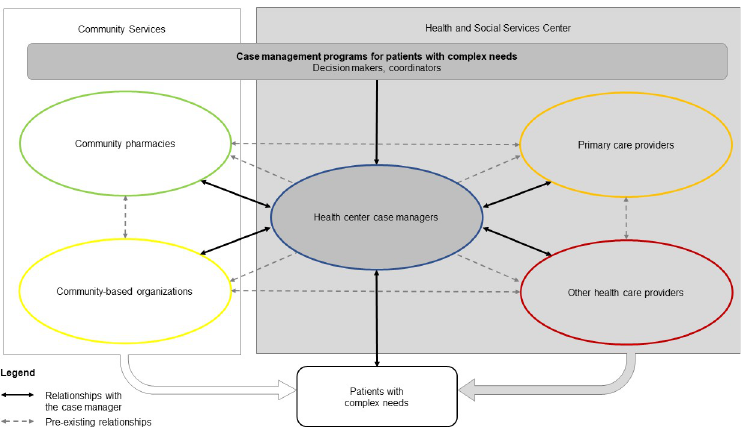
Fig 1. Relationships between stakeholders engaged in